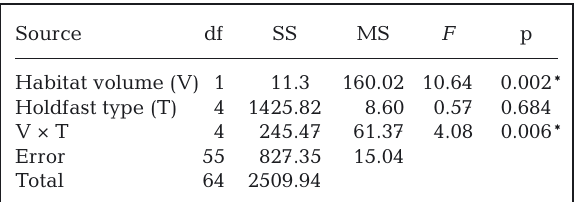
Table 2. ANCOVA data from number of species vs. holdfast types with habitat volume as a covariate. There are 5 hold- fast types: the Laminaria digitata and L. ochro leuca from the Blight & Thompson (2008) study benthic material collected in Ireland and 2 sowing dates of suspended L. digitata holdfasts from aquaculture longlines (present study). The 2 sowing dates were not pooled for species richness as a preliminary ANCOVA suggested inhomogeneity of slopes. *Significant difference at p < 0.05